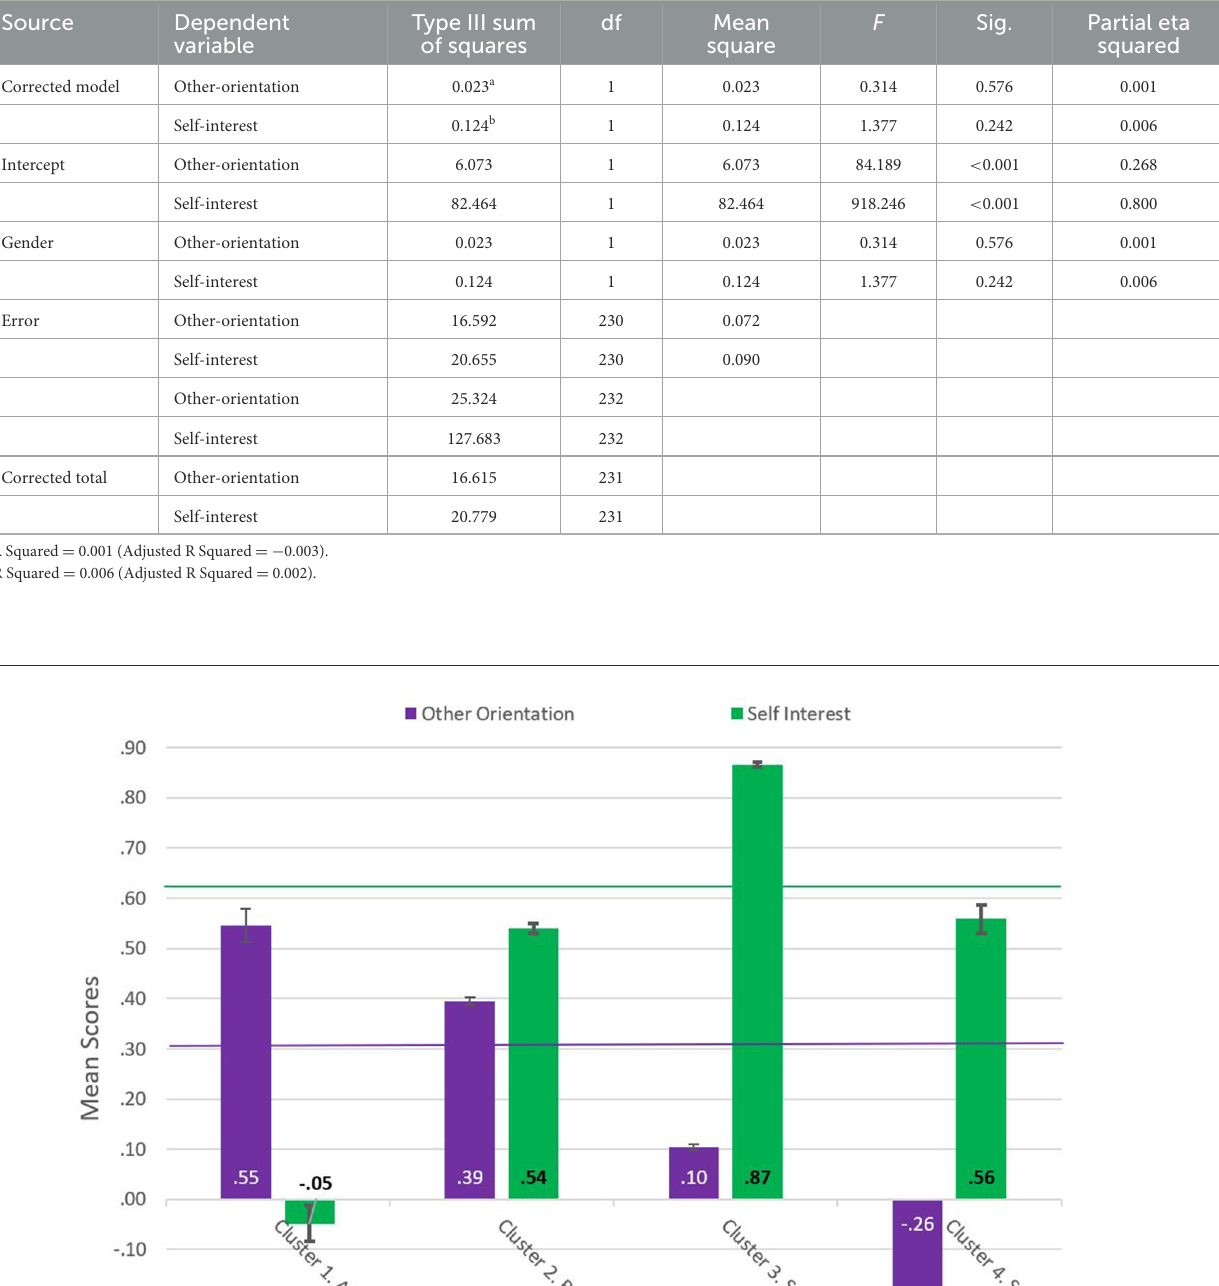
TABLE 5 One-way MANOVA tests of between-subjects effects on other-orientation and self-interest simultaneously of the veterinary sub-population ( n = 232).